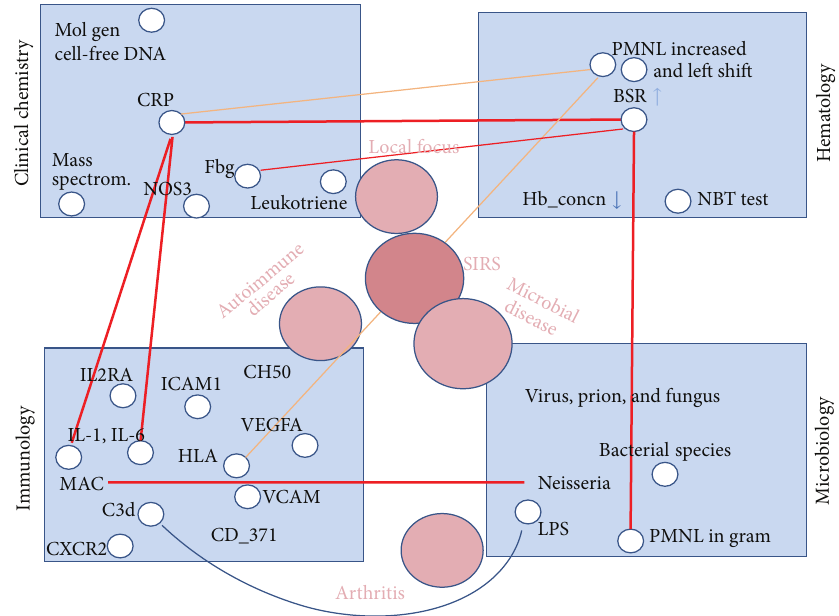
Figure 4: Analyses from different sections of the medical laboratory must be pulled together to establish evidence for inflammation. Similar to the display in Figure 2, the 4 major specialities, clinical chemistry, haematology, immunology, and microbiology, each encompass a whole array of inflammation markers. Networking across lab specialities obtrudes to pin down inflammatory disturbance. Complement analytics placed in the “immunology” box. Red bars connect strong evidence, while orange bars show medium evidence for denoted disease states. The insinuated disease states are placed